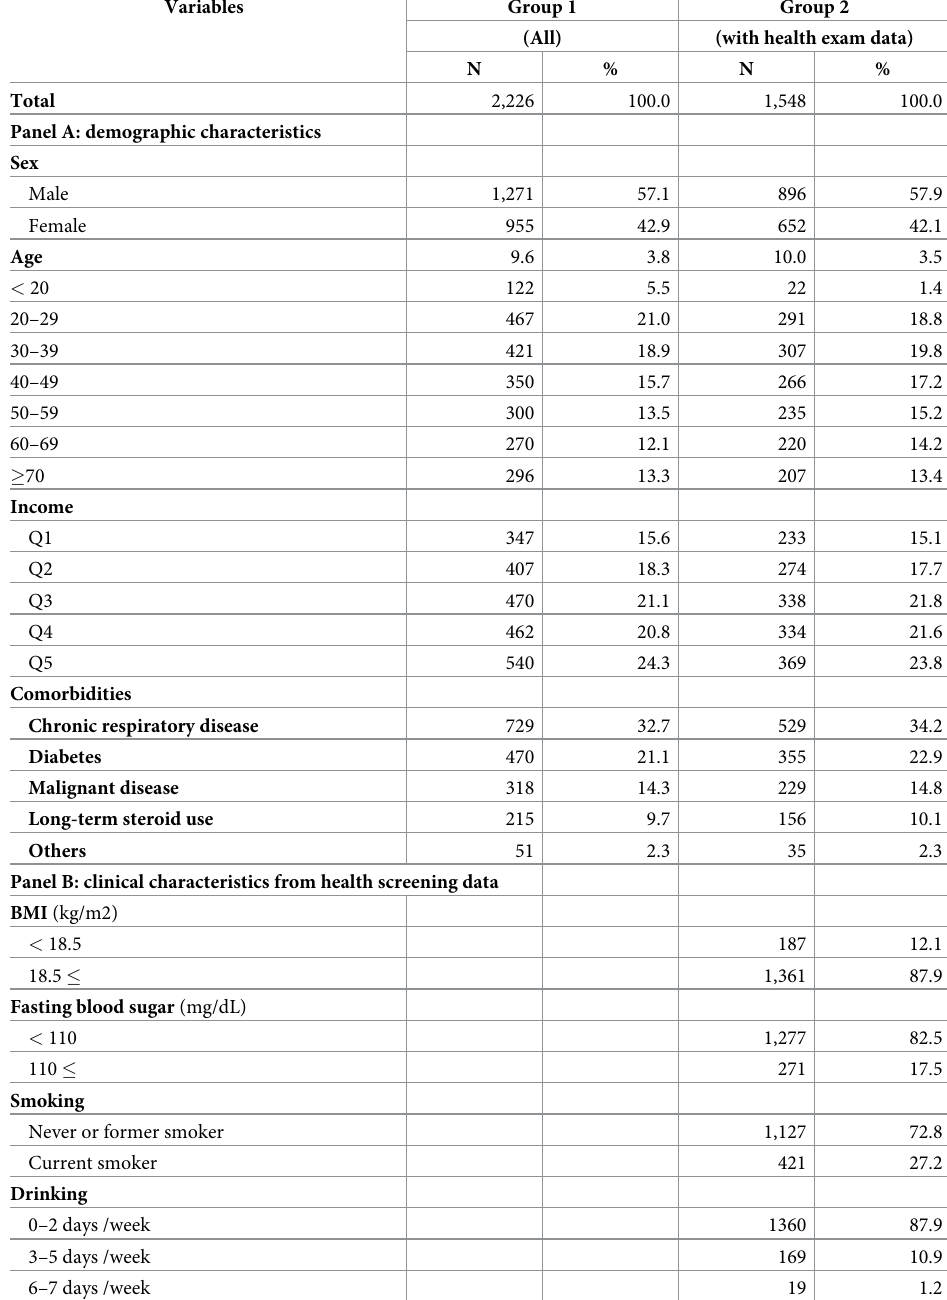
Table 1. Characteristics of study